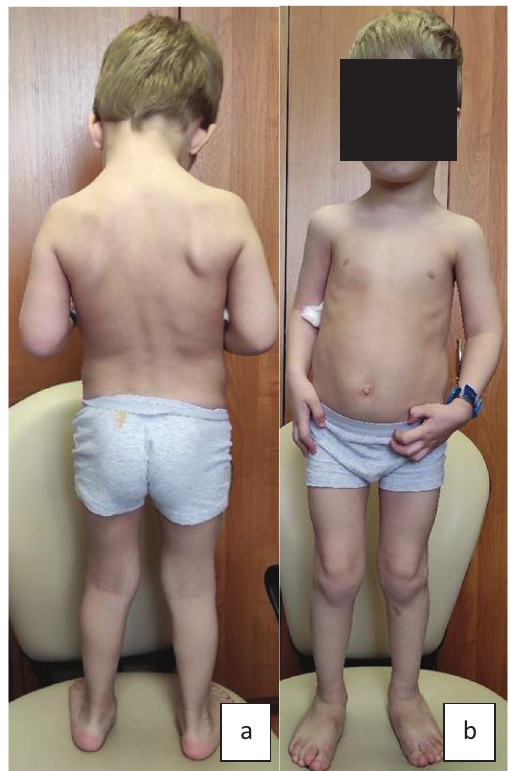
Figure 2. Proband no. 5: a) thoracolumbar levokyphoscoliosis of the 2 nd degree; b) epicanthic fold, genu valgum, pes (Patient no. 4), mild bilateral mixed hearing loss was detected in a three-year-old boy (Patient no. 5). Ophthalmologic problems were diagnosed in three children, and the most severe alterations were in the 15-year-old boy (Patient no. 4). He had progressive high myopia with astigmatism and right side chorioretinitis without signs of inflammation. Patient